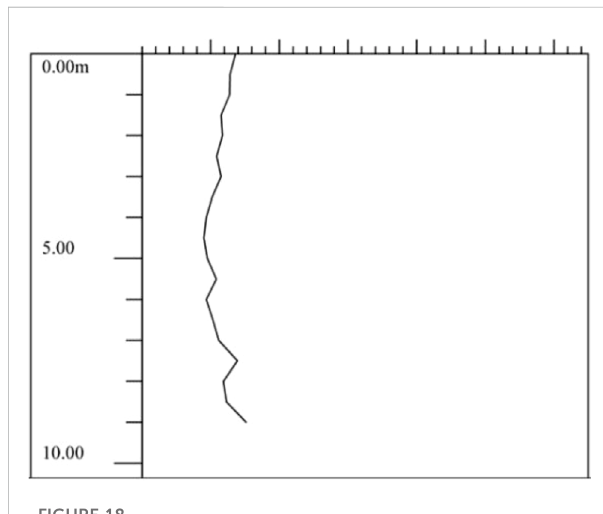
FIGURE 18 Test results of acoustic method at Cross-section YK330+855.